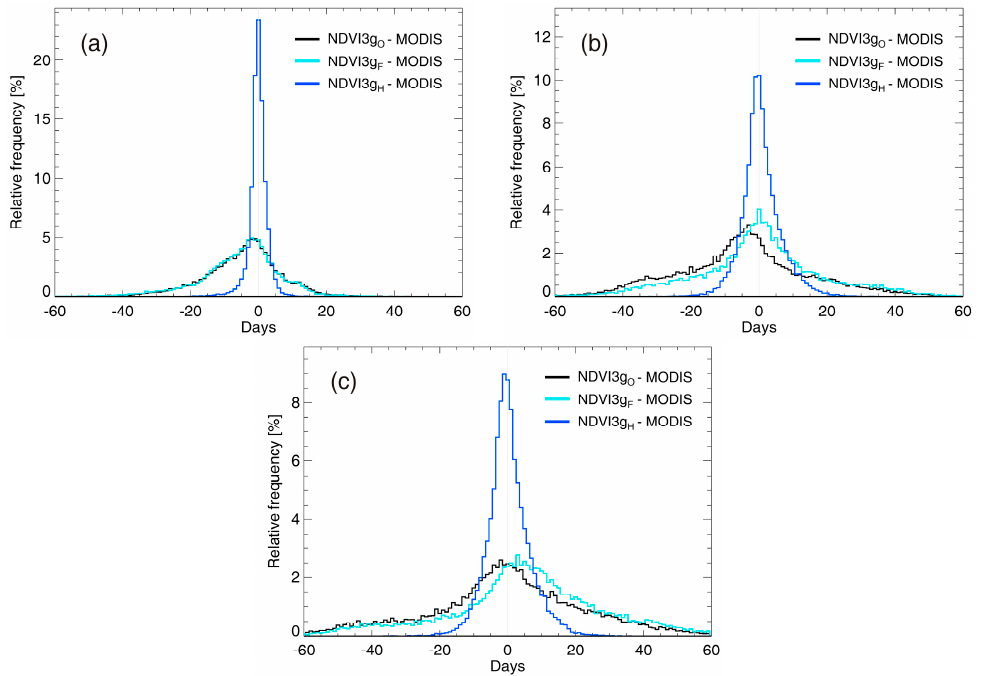
Figure 3. Frequency distribution of ( a ) SOS bias; ( b ) EOS bias; ( c ) length of growing season bias during the time period of 2000–2013 for NDVI3g O (black), NDVI3g F (light blue) and NDVI3g H (dark blue) datasets relative to NDVI MODIS . Positive bias means earlier SOS, EOS and shorter LOS for MODIS (n = 20191).